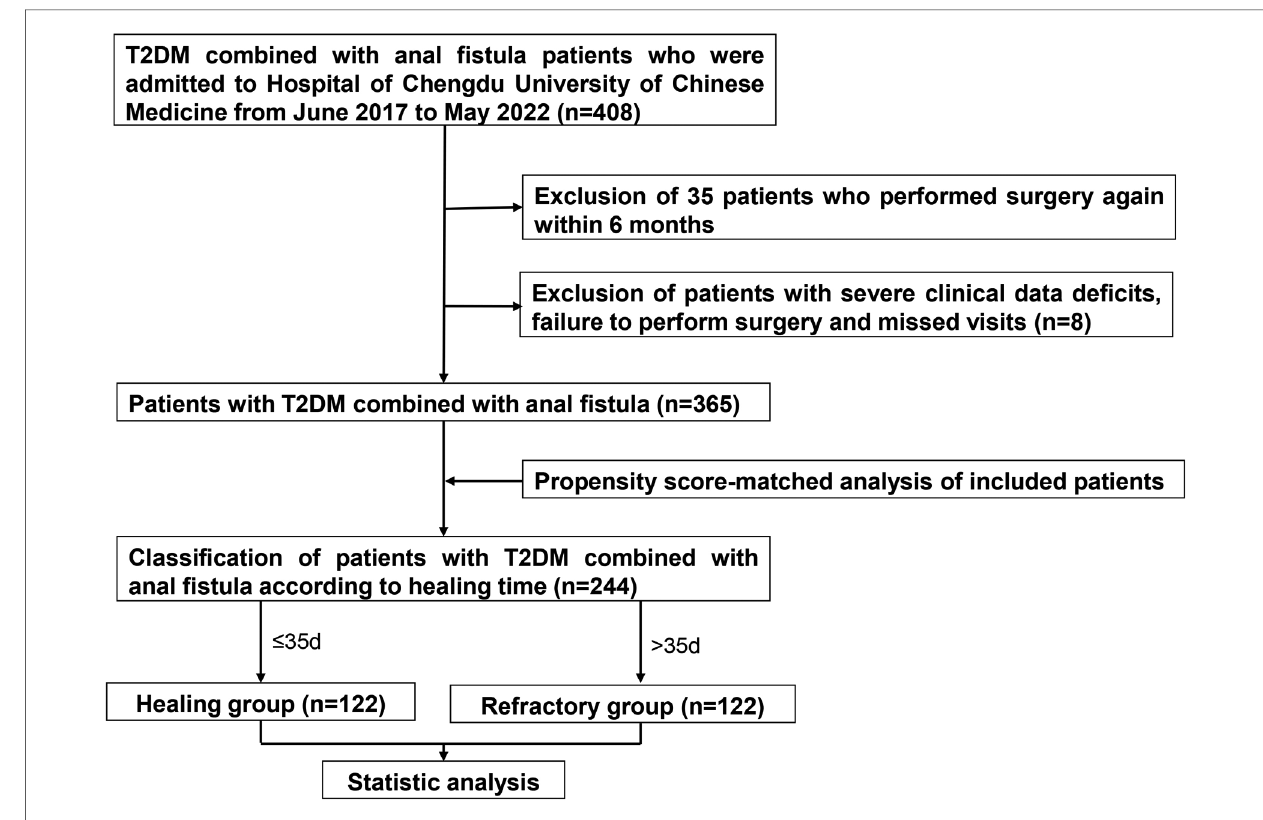
FIGURE 1 Research fl ow